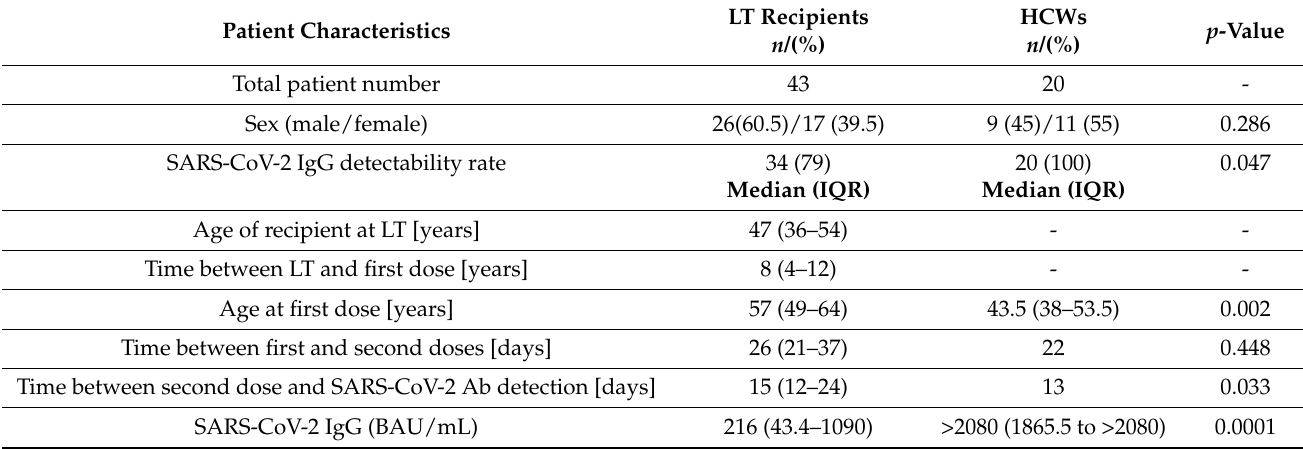
Table 1. Patient characteristics are presented as absolute number n and percentage or median and interquartile range.